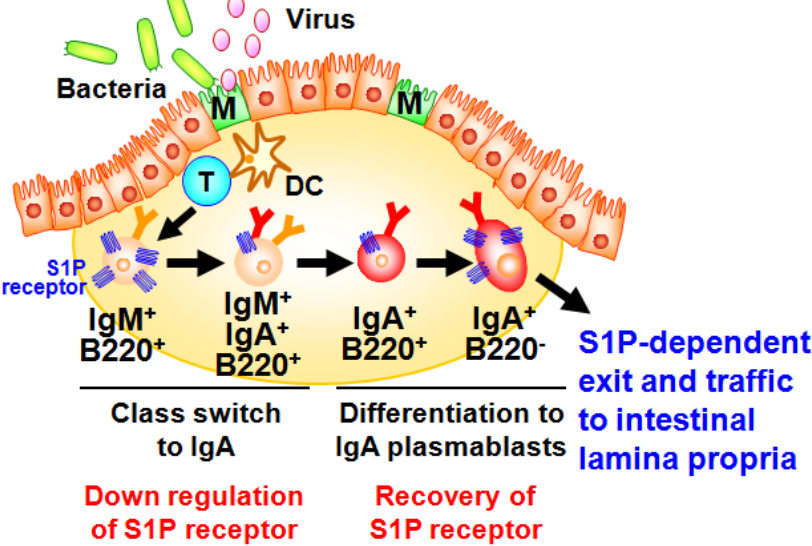
Figure 2. Sequential changes in S1P1 expression during B-cell differentiation in Peyer’s patches. Dendritic cells (DC) take the antigens transported by M cells from intestinal lumen and present them to T cells for their activation. Through the interaction with T cells and DCs, IgM + naive B cells show class-switch from IgM to IgA. During this process, S1P1 is expressed at high levels in IgM + naive B cells and downregulated on B cells class-switching from IgM to IgA and subsequently recovered on IgA + B220 − plasmablasts, resulting in their emigration from the Peyer’s patches and traffic into the intestinal lamina